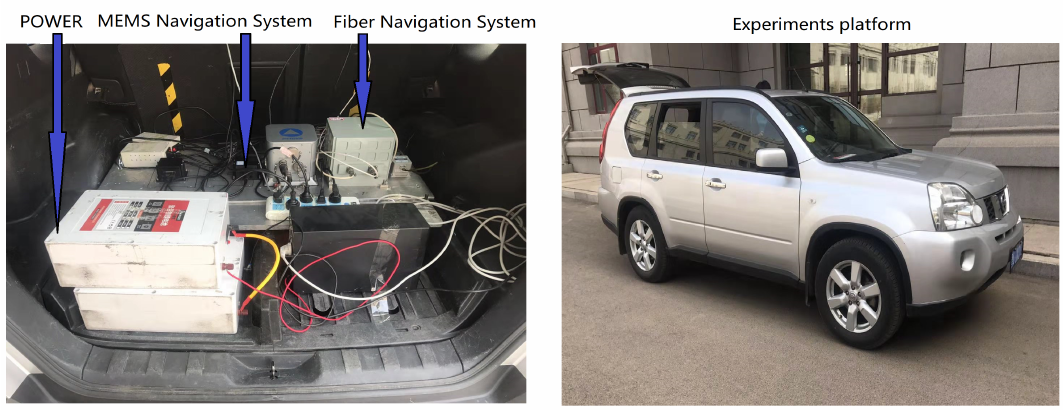
Figure 3. Experiments’ platform.